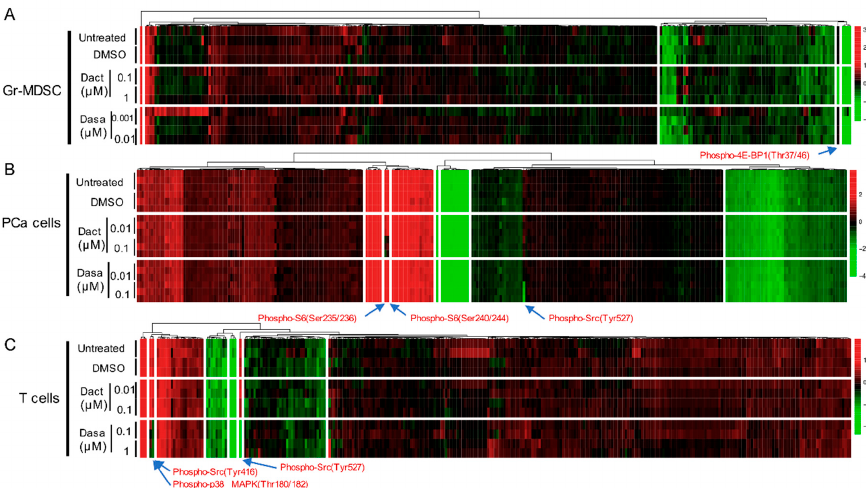
Figure 2. Heatmaps showing the normalized protein expression signals under no treatment or 2 h treatment of DMSO, Dactolisib or Dasatinib (at indicated concentration) for Gr-MDSCs ( A ) , PCa cells ( B ), and T cells ( C ). Proteins with significant changes under either inhibitor treatment are labeled with arrows. Dact = Dactolisib, Dasa = Dasatinib. Arrows highlight the differentially expressed proteins or PTMs by the inhibitor treatment.